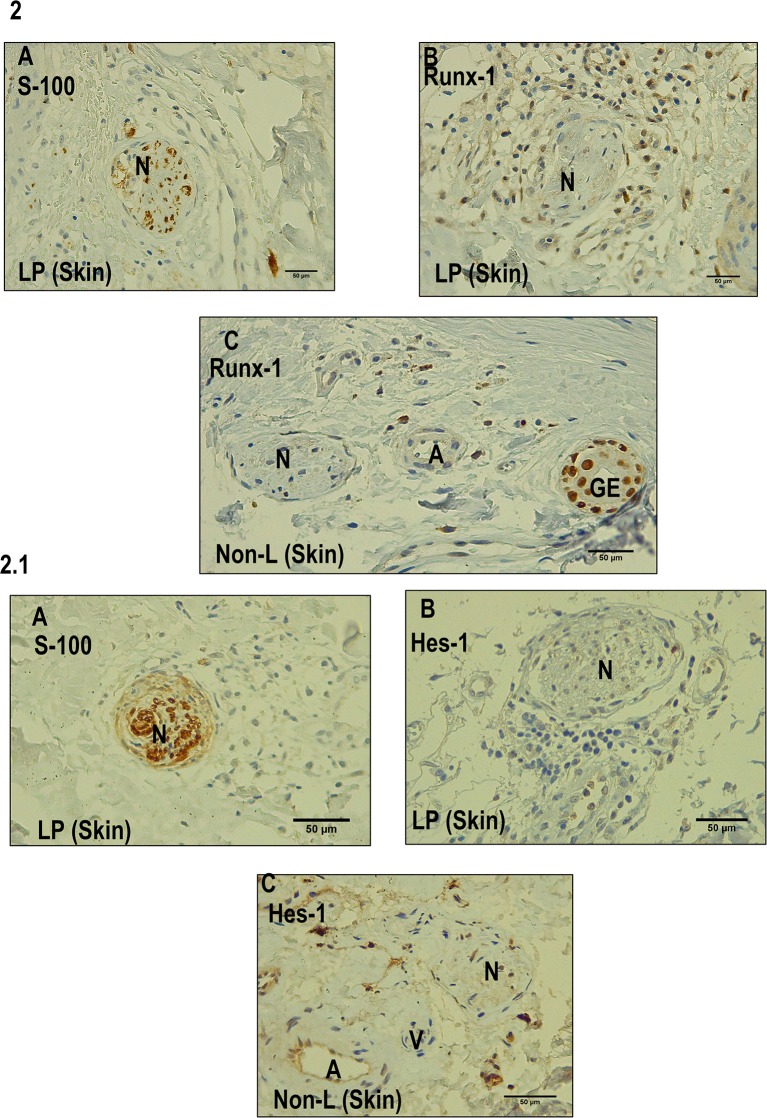
Immunohistochemistry with Runx-1 and Hes-1 in dermal nerves (leprosy skin and non-leprosy skin). (A) Dermal nerve (N) stained with S-100 in a leprosy sample (LP). (B) Dermal nerve (N) in a leprosy patient (LP) negative for Runx-1. (C) Dermal nerve (N) 1 in a non-leprosy sample (non-LP) negative for Runx-1. A: artery, EG: eccrine glands. All the figures have a 50-μm scale bar. 2.1 (A) A dermal nerve (N) stained with S-100 in a leprosy sample (LP). (B) Dermal nerve (N) in leprosy sample (LP) negative for Hes-1. (C) Dermal nerve in a sample non-leprosy (Non-LP) negative for Hes-1. A: artery, V: venule, N: nerve. All the figures have a 50-μm scale bar.